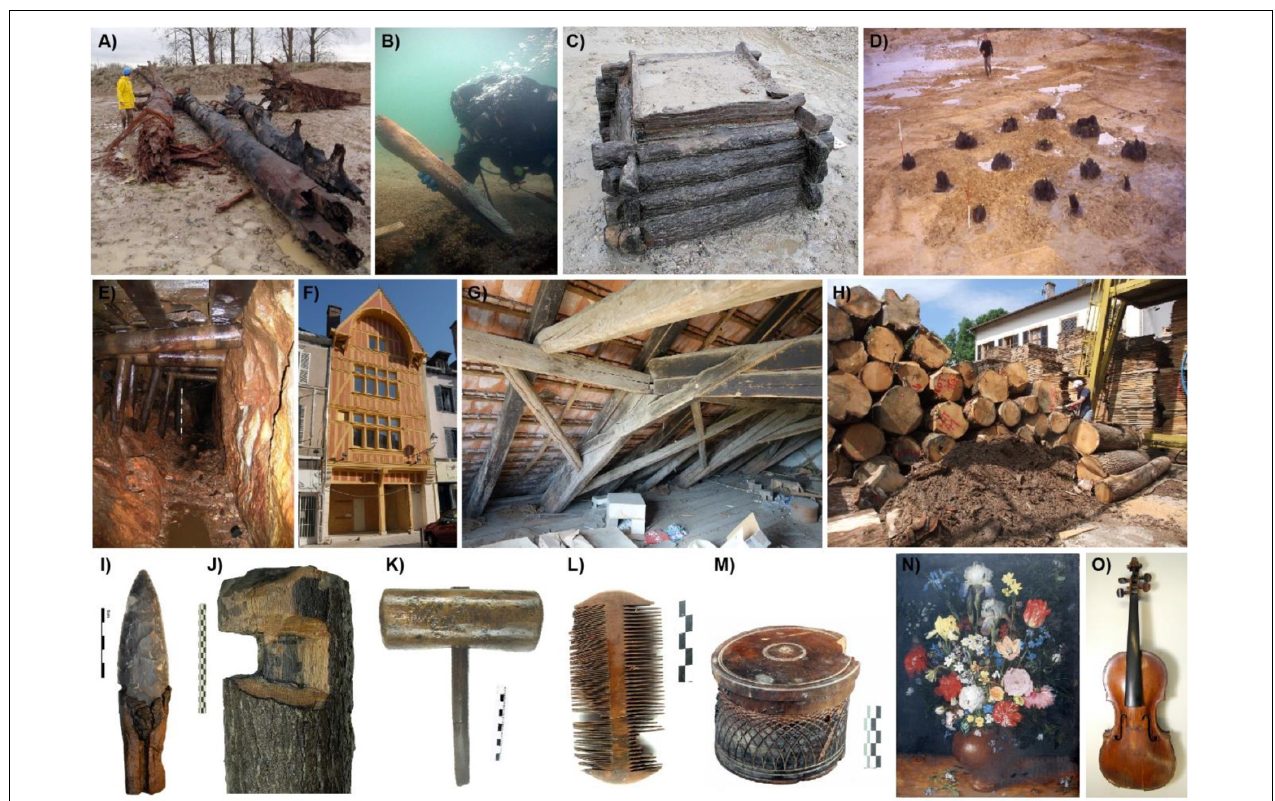
FIGURE 1 | Wood sources for dendroarchaeological research: (A) Subfossil trees from a gravel pit in the Upper Rhine Valley (Leutenheim, France). (B) Neolithic pile excavated underwater in Oehningen-Orkopf, Lake Constance, Switzerland. (C) Water well lining from the Late Bronze Age, excavated in Erstein, France. (D) Post foundation of a Roman building in Vendresse, France. (E) Medieval silver mining gallery in the Black Forest (Schauinsland, Germany). (F) Half-timbered house in Troyes, France. (G) Late medieval roof truss in Langenrickenbach, Switzerland. (H) Modern sawmill in Many, France. (I) Neolithic knife with flint blade and wooden handle from Allensbach, Germany. (J) Late Bronze Age construction timber from Erstein, France. (K) Late Iron Age wooden hammer from Saverne, France. (L) Roman comb and (M) box from Troyes, France. (N) Modern painting and (O)